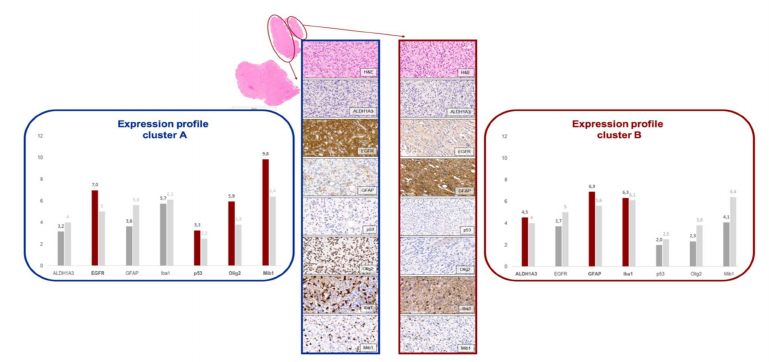
Figure 4. Characteristic immunohistochemical profile of both subtypes. The blue frame marks the classical subtype, the red the mesenchymal subtype. For each, the average IRS of all markers are pictured in the bar charts. Basis is the cluster assignment of PAM. Red bars are used for markers that exceed the average IRS. The light grey bars depict the average IRS for all